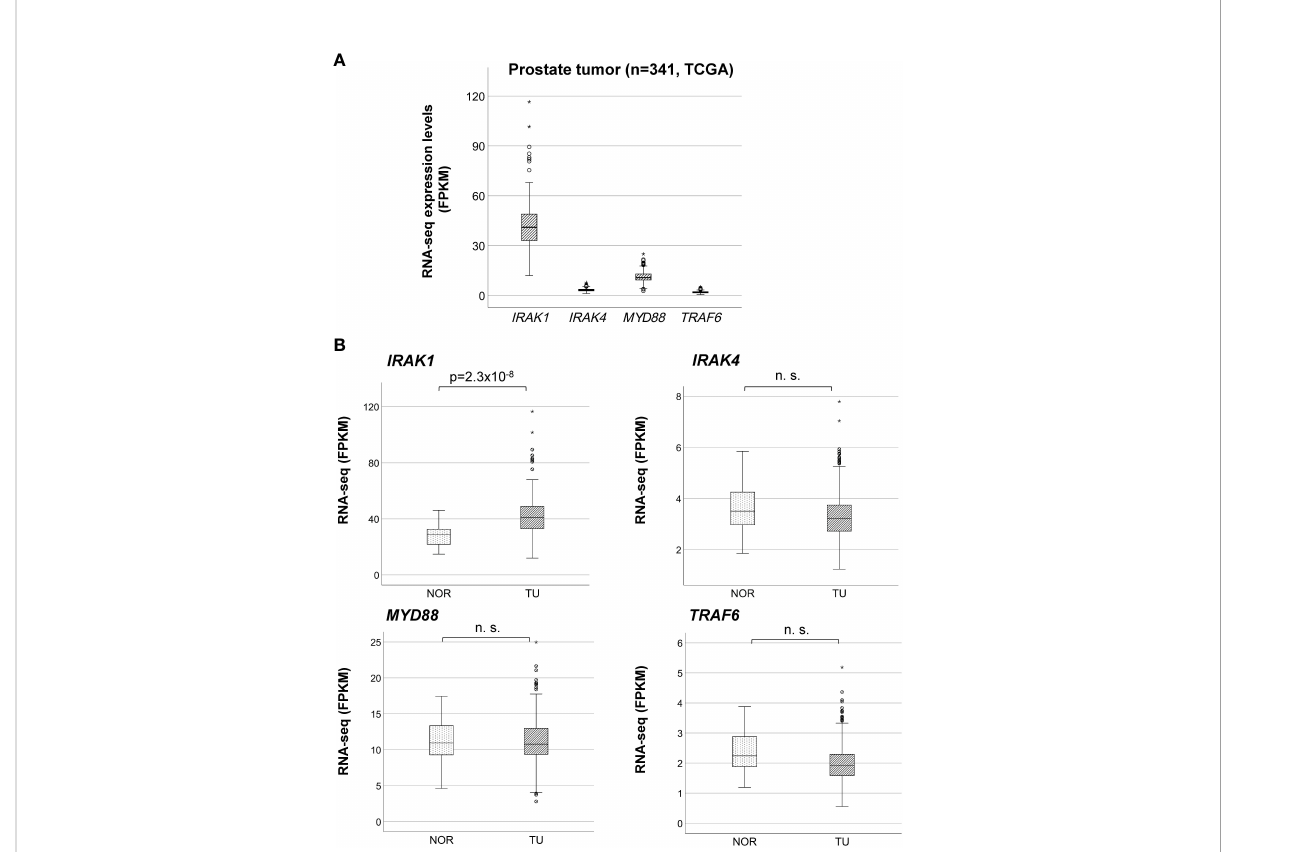
FIGURE 2 Overexpression of IRAK1 in prostate cancer. (A) Comparison of bulk mRNA expression levels of IRAK1 , IRAK4 , Myd88 and TRAF6 in prostate cancer. Relative RNA expression is given in fragments per kilo base per million mapped reads (FPKM). (B) Differential mRNA expression analysis of IRAK1 , IRAK4 , Myd88 and TRAF6 in normal (NOR) and cancer (TU) prostate tissue. Signi fi cant difference was found only for IRAK1 (eBayes, Benjamini-Hochberg adjusted p-value). n. s., not signi fi cant